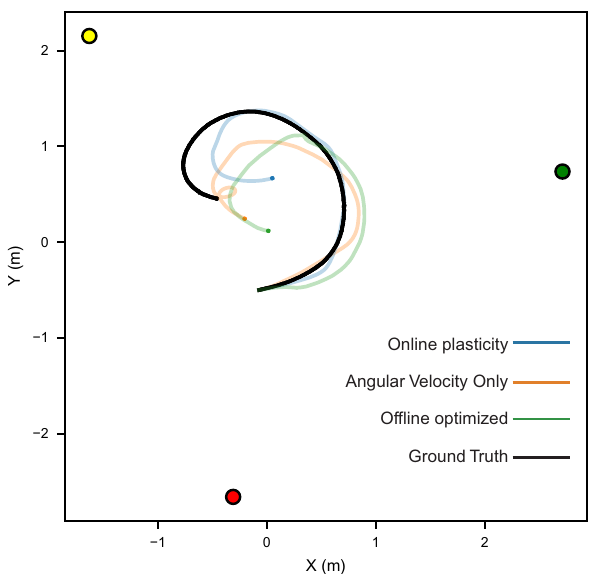
Figure 5. Trajectory estimation. In the arena, position estimates from each model configuration share features of the overall trajectory (best seed) with the ground truth trajectory. Landmark positions are denoted with colored circles. Final positions in the trajectory estimates are denoted with a small